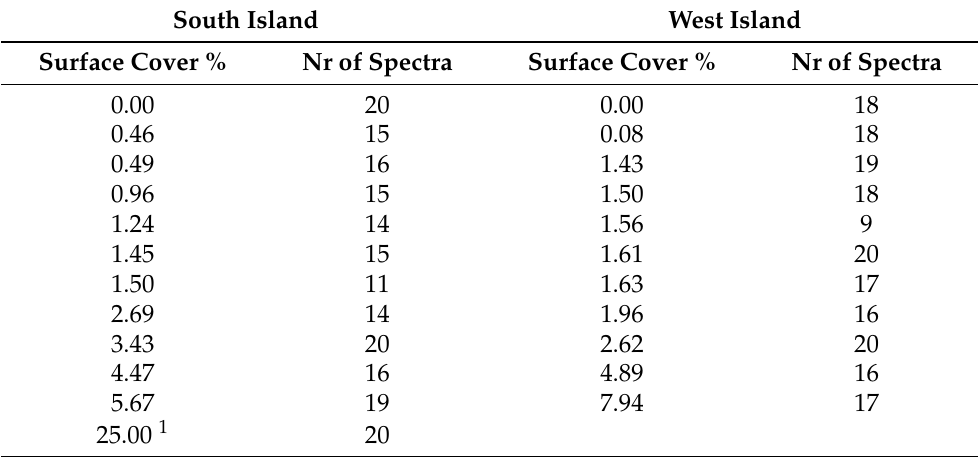
Table 1. Quadrat samples from two field sites (South Island and West Island), with surface cover of plastic debris and the final number of spectra used in analysis.In order to get a representative sample of each quadrat, the spectra were averaged to create one reading per quadrat. An additional quadrat with intentionally created surface cover of 25% was also included for